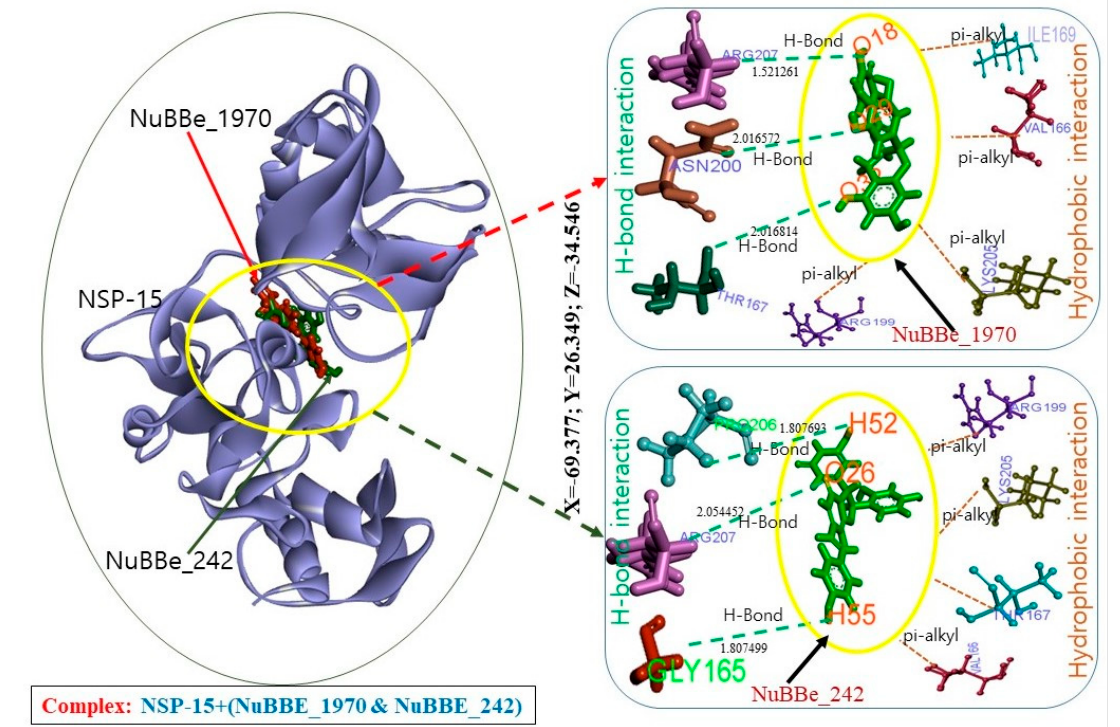
Figure 2. Complex structures of NuBBE-1970 and NuBBE-242 with active site of NSP15.